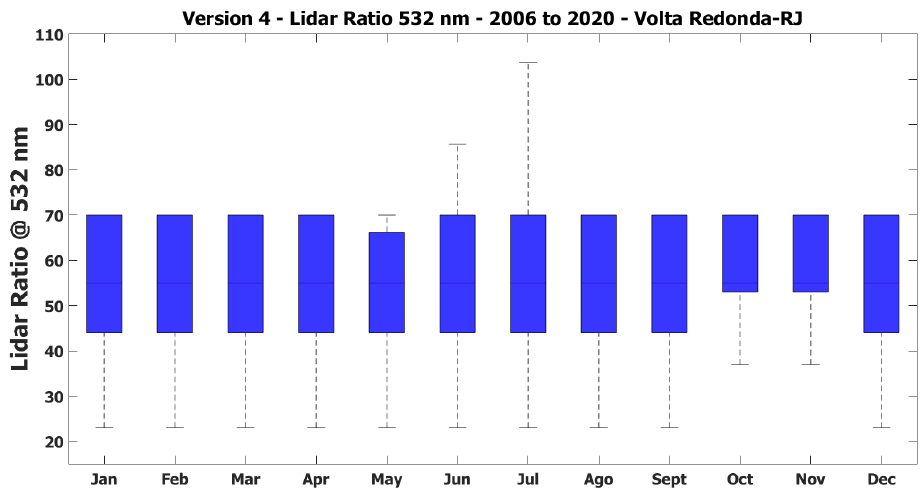
Figure 3. Whisker plots of the monthly AOD and lidar ratio from CALIOP/CALIPSO products at 532 nm over Volta Redonda-RJ, for the period of June of 2006 to December of 2020.